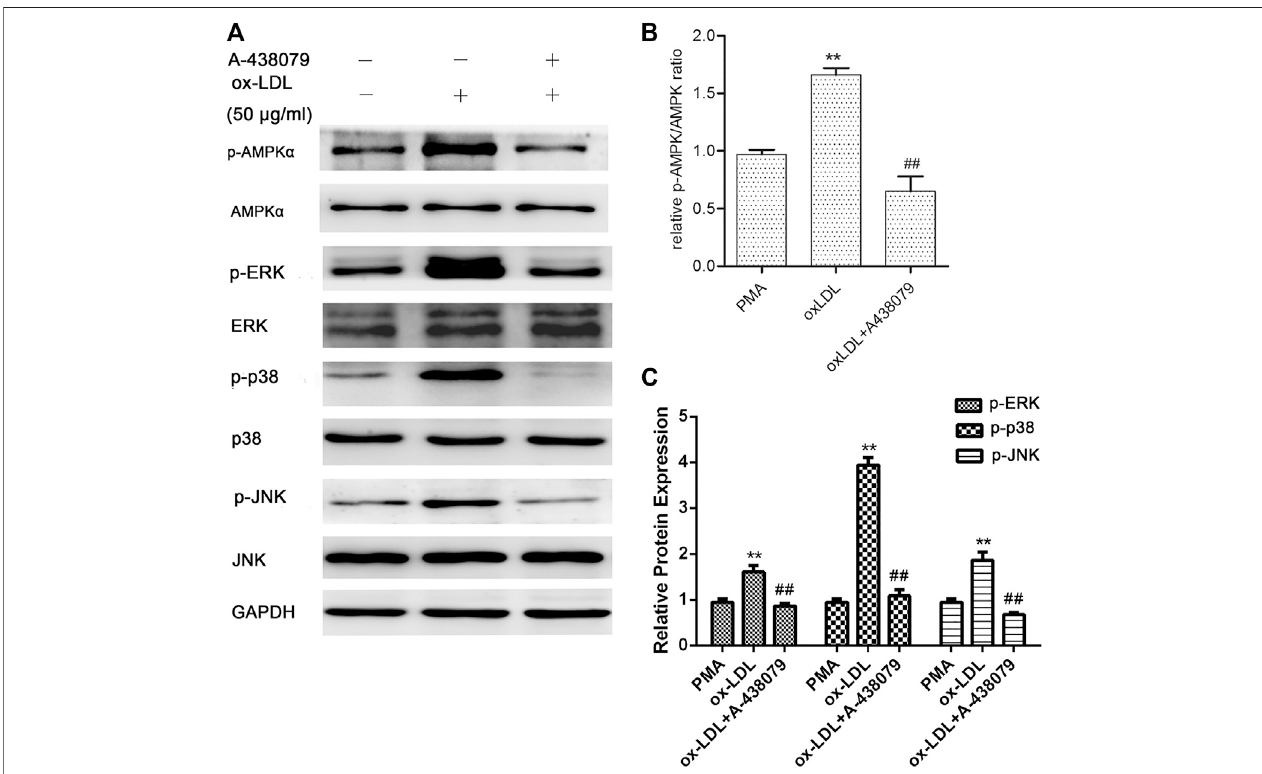
FIGURE3| EffectofA-438079onthephosphorylationofAMPK α ,ERK1/2,p38,andJNK.ThephosphorylationofAMPK α ,ERK1/2,p38,andJNKwasmeasured by Western blotting. Densitometry measurements of phosphorylated AMPK α , ERK1/2, p38, and JNK were normalized to total AMPK α , ERK1/2, p38, and JNK, respectively. The band densities were measured by Quantity One 1D analysis software. The data (means ± SD) were obtained from three independent experiments. ** p < 0.01 compared with PMA, ##: p < 0.01 compared with the oxLDL